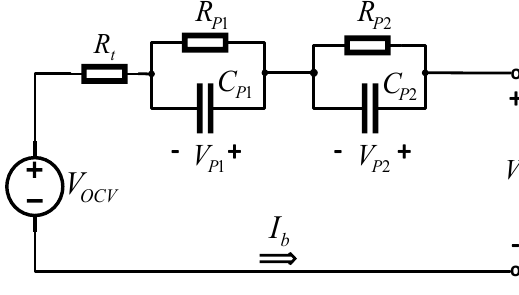
Figure 5. Second-order ECM.